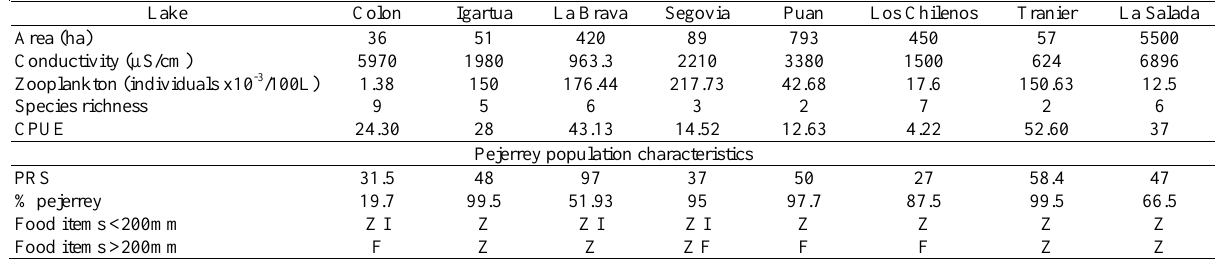
Table 1. Limnological characteristics and pejerrey population features in study lakes. Z: zooplankton; F: fish; I: insects. PRS: proportional reproductive stock. CPUE: catch per unit effort.